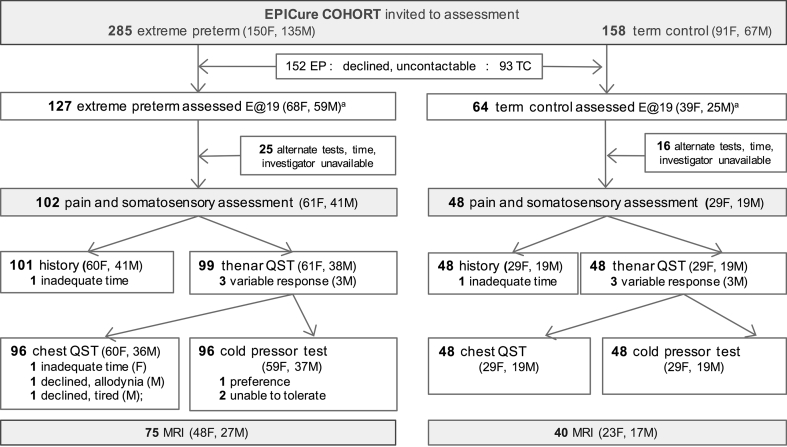
EPICure recruitment and assessment flowchart. E@19, EPICure at 19 yr study; F, female; M, male; QST, quantitative sensory testing.